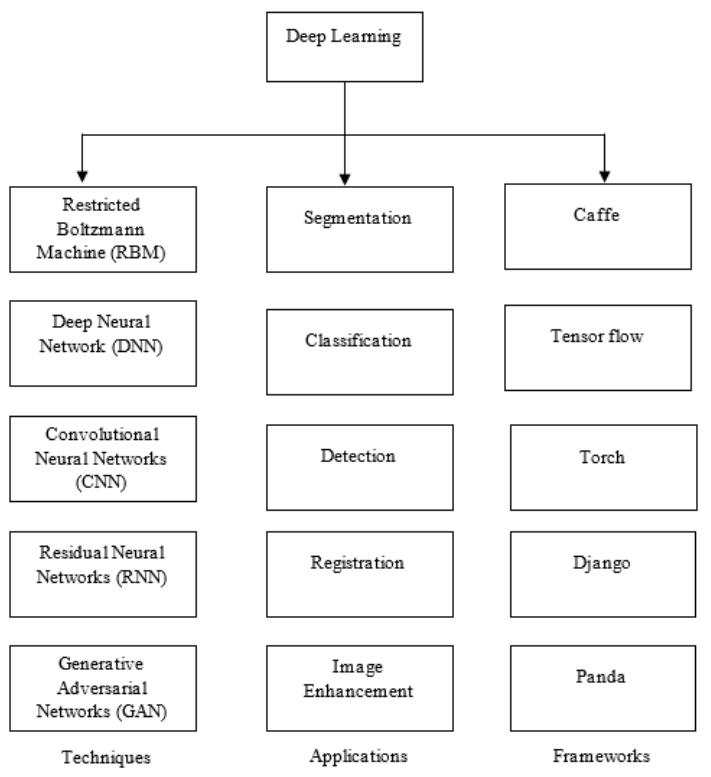
Figure 2. Overview of deep learning techniques, applications, and